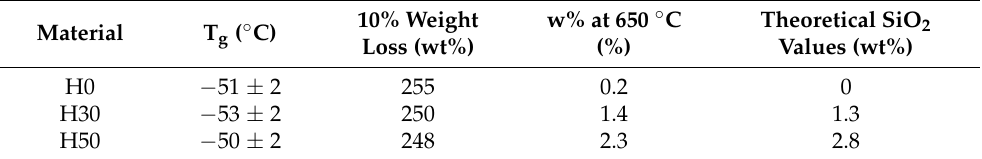
Table 2. Glass transition temperatures and weight loss for H0, H30 and H50 films.